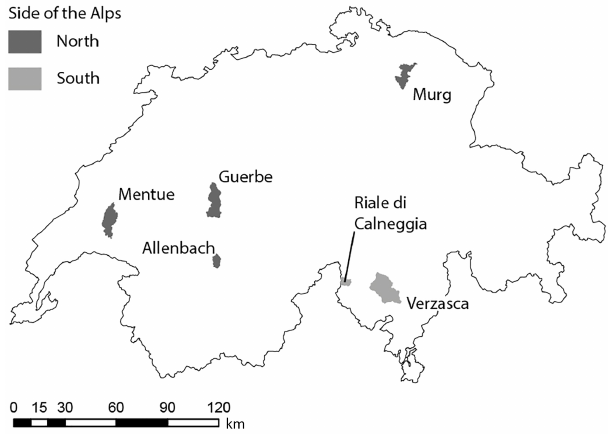
Figure 1. Location of the six study catchments in Switzerland. Shading indicates whether the catchment is located on the north or south side of the Alps. See Table 1 for the characteristics of the study catchments.